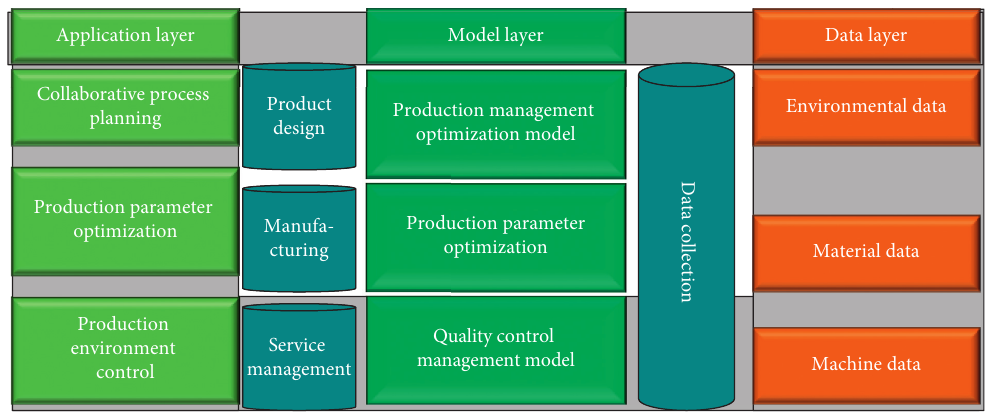
Figure 4: Frame structure of DTs and production process.